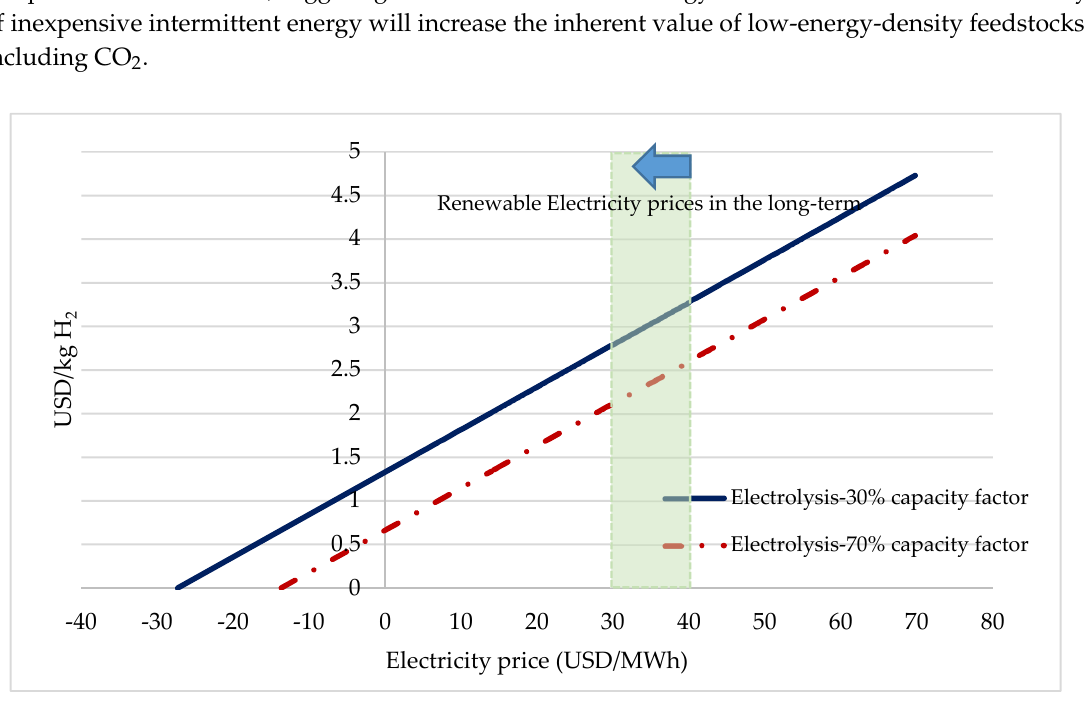
Figure 1. Near-term hydrogen production cost versus electricity price [25]. Negative electricity prices reflect local intermittent excess production (extrapolated from the original data). A full load hours (FLH) value of about 4000 h is assumed. For more information on the underlying assumptions refer to [25].